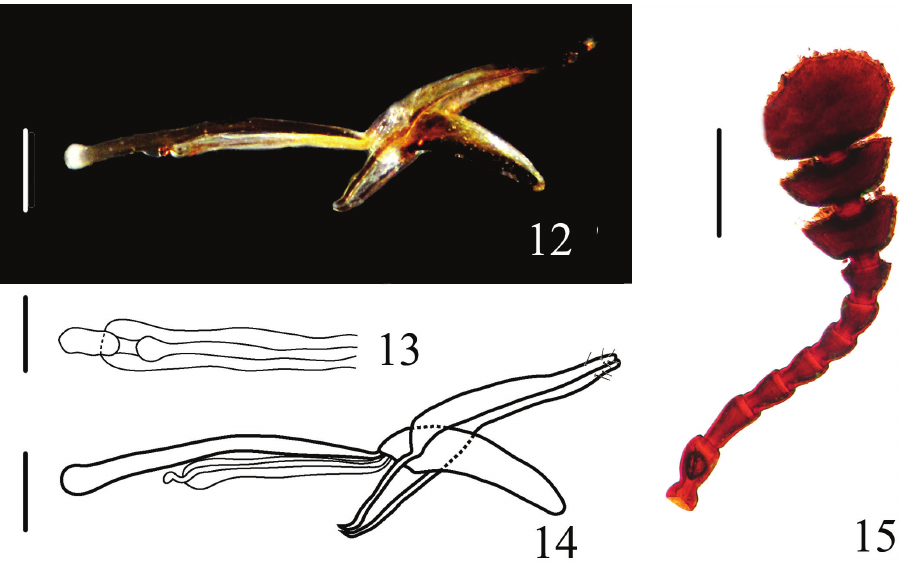
Figures 12–15. Dacne ( Xenodacne) hujiayaoi . 12, 14 aedeagus in lateral views 13 internal sac and flagel- lum in dorsal view 15 antenna. Scales = 0.05 mm( 13 ), Scales = 0.2 mm( 12, 14, 15 ).